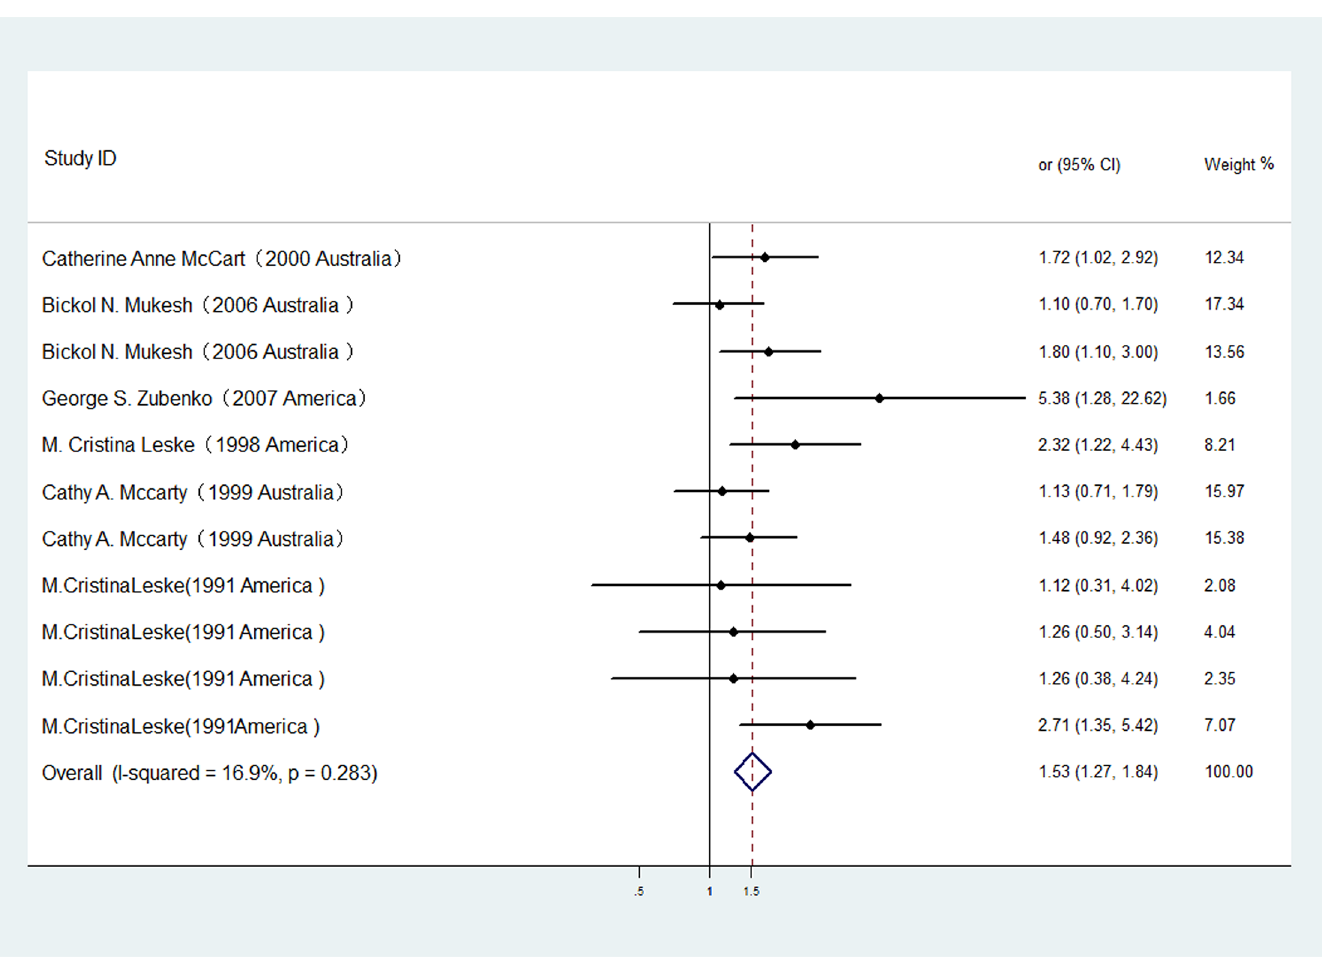
Fig 2. The association of gout with cataractrisk in case-control/cross-sectional studies.